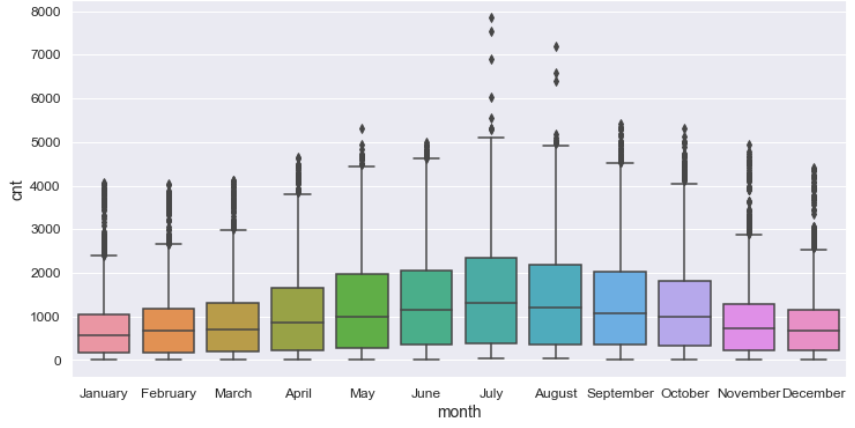
Figure 6. Average shared bike usage per mouth.